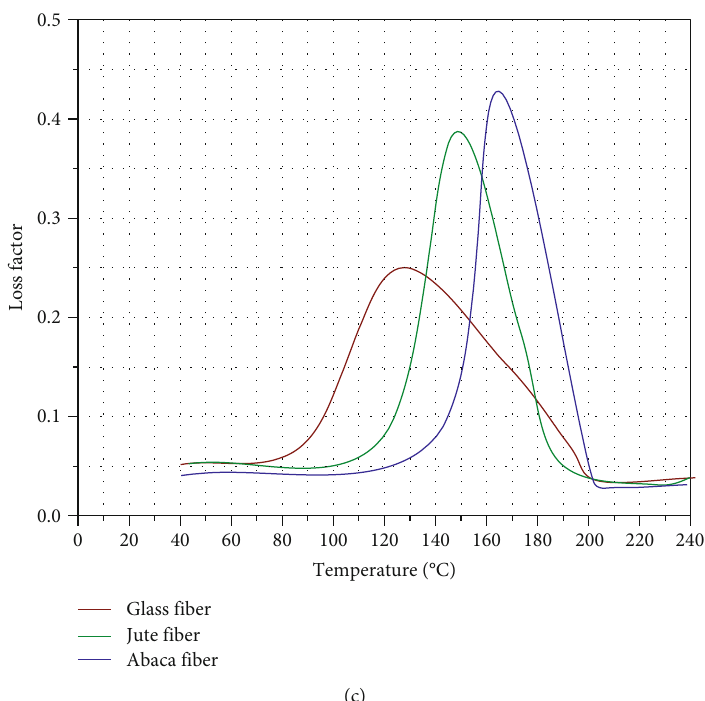
Figure 2: (a) Storage modulus. (b) Loss modulus. (c) Loss factor of circumferential composites at a single